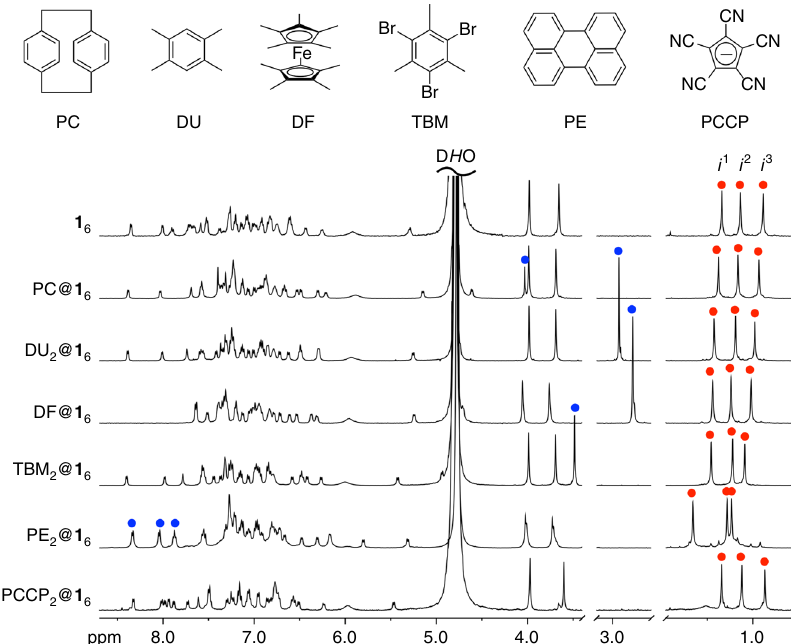
Fig. 2 1 H NMR spectra of the host-guest complexation between the nanocube and guest molecules (500 MHz, D 2 O, 298 K). Red solid circles indicate the p -tolyl methyl signals ( i 1 , i 2 , and i 3 ). Blue solid circles indicate the signals for guest molecules encapsulated in the nanocube. The most down fi eld-shifted four signals (DF@ 1 6 and PE 2 @ 1 6 ) derived from the protons neighboring nitrogen atoms of the N -methylpyridinium groups in 1 6 disappeared through the H/ D exchange with D 2 O upon heating at 90 °C